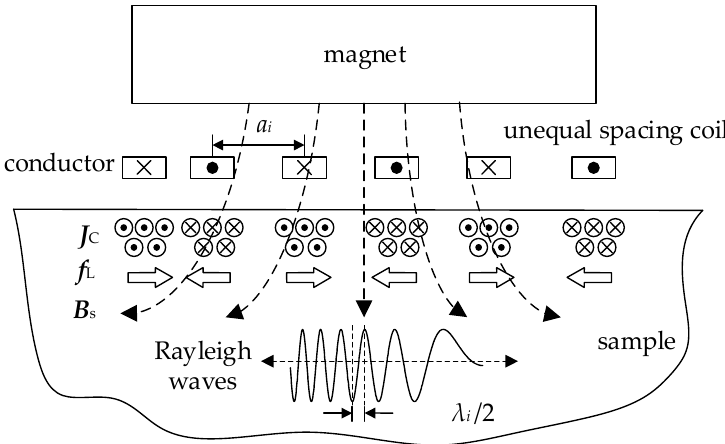
Figure 1. Mechanism of RW-EMAT with UES.